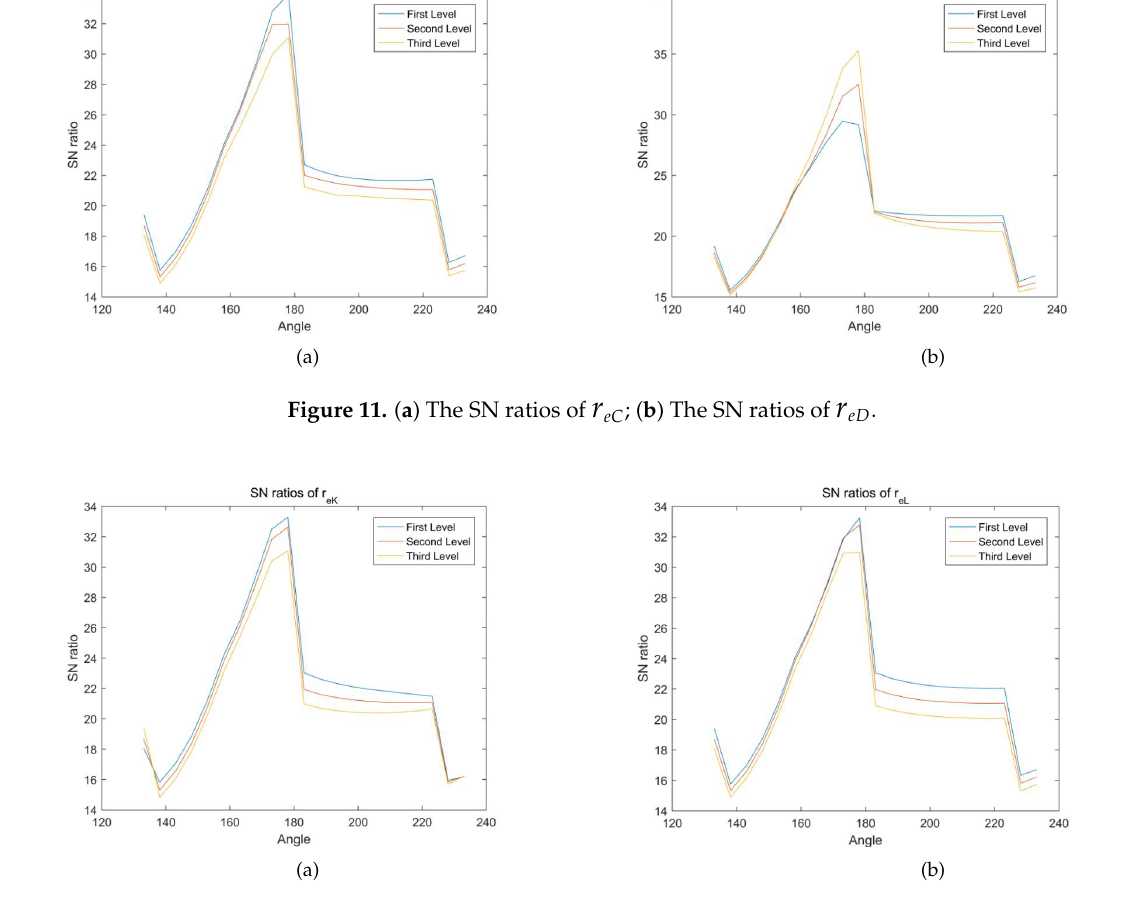
Figure 12. ( a ) The SN ratios of r eK ; ( b ) The SN ratios of r eL